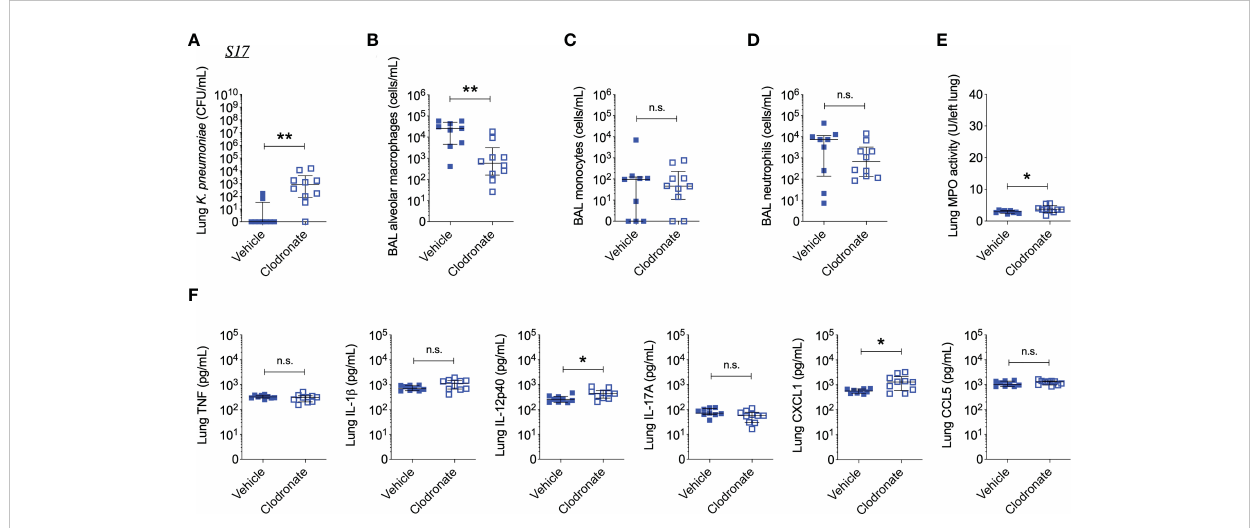
FIGURE 5 Alveolar macrophage depletion with clodronate results in increased bacterial burden and in fl ammation in mice infected with the phagocytosis- sensitive S17 isolate. (A) CFU of Kp in lung homogenates obtained from C57BL/6J mice treated with clodronate (N=10, intratracheal, 0.5mg/mouse) or empty liposomes (N=9) and subsequently infected with S17 Phago-Sens (inoculum: 10 3 CFU) for 24 hours. (B) Numbers of alveolar macrophages, (C) monocytes, and (D) neutrophils in BAL specimens from S17-infected mice treated with clodronate or vehicle, as determined by fl ow cytometry. (E) MPO activity in lung tissue homogenates from S17-infected mice treated with clodronate or vehicle. (F) Levels of TNF, IL-1 b , IL-12p40, IL-17A, CXCL1, and CCL5 in lung tissue homogenates from S17-infected mice as determined by ELISA. Data represent medians ± interquartile range (A – D, F) or means ± SD (E) + individual data points. *p<0.05, **p<0.01, n.s.: not signi fi cant (A – D, F) : Mann-Whitney test; (E) : t test with Welch ’ s correction).